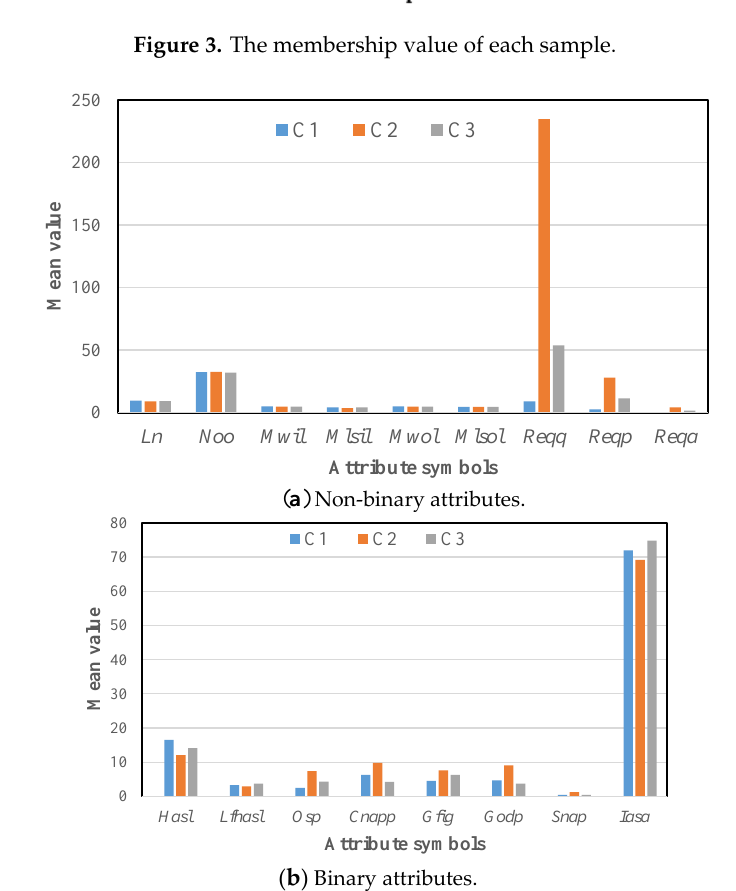
Figure 4. Comparison of mean value of attributes in each category. Table 2. Numbers of samples within the three categories with different